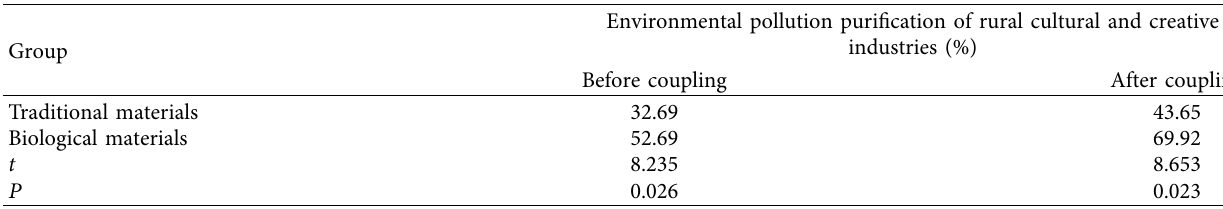
Table 3: Coupling degree of different materials to purified environmental pollution.